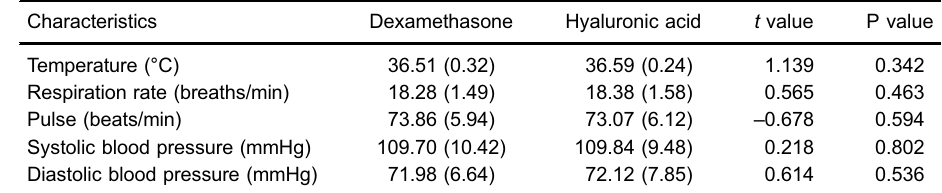
Data are reported as means and standard deviations for n=52 children/group ( t